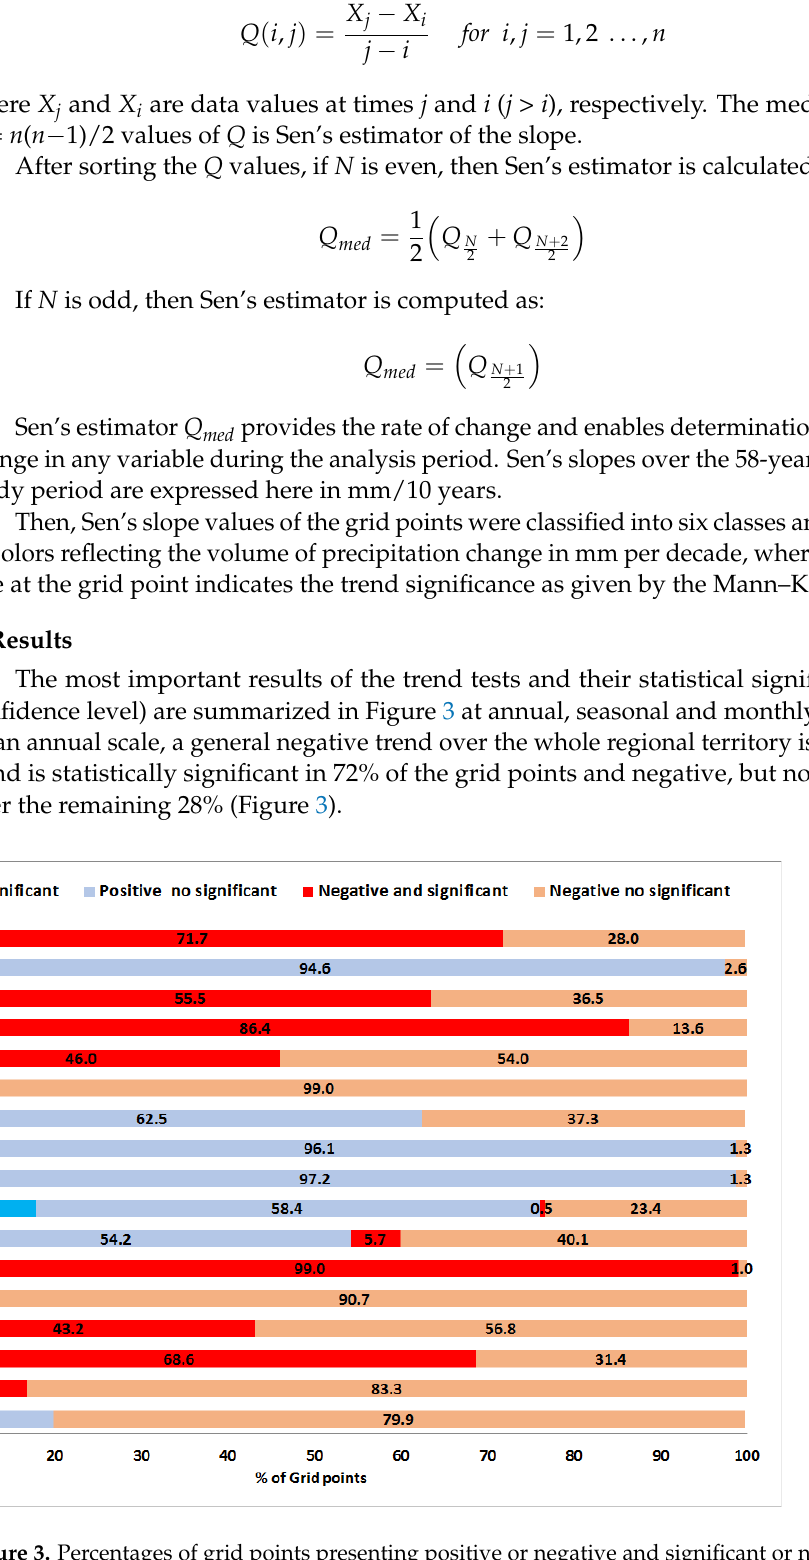
Figure 4. Theil – Sen estimator and MK test at annual time scale. Squares ’ dimensions indicate the significance level of the trend: large squares: p < 0.05, small squares otherwise.